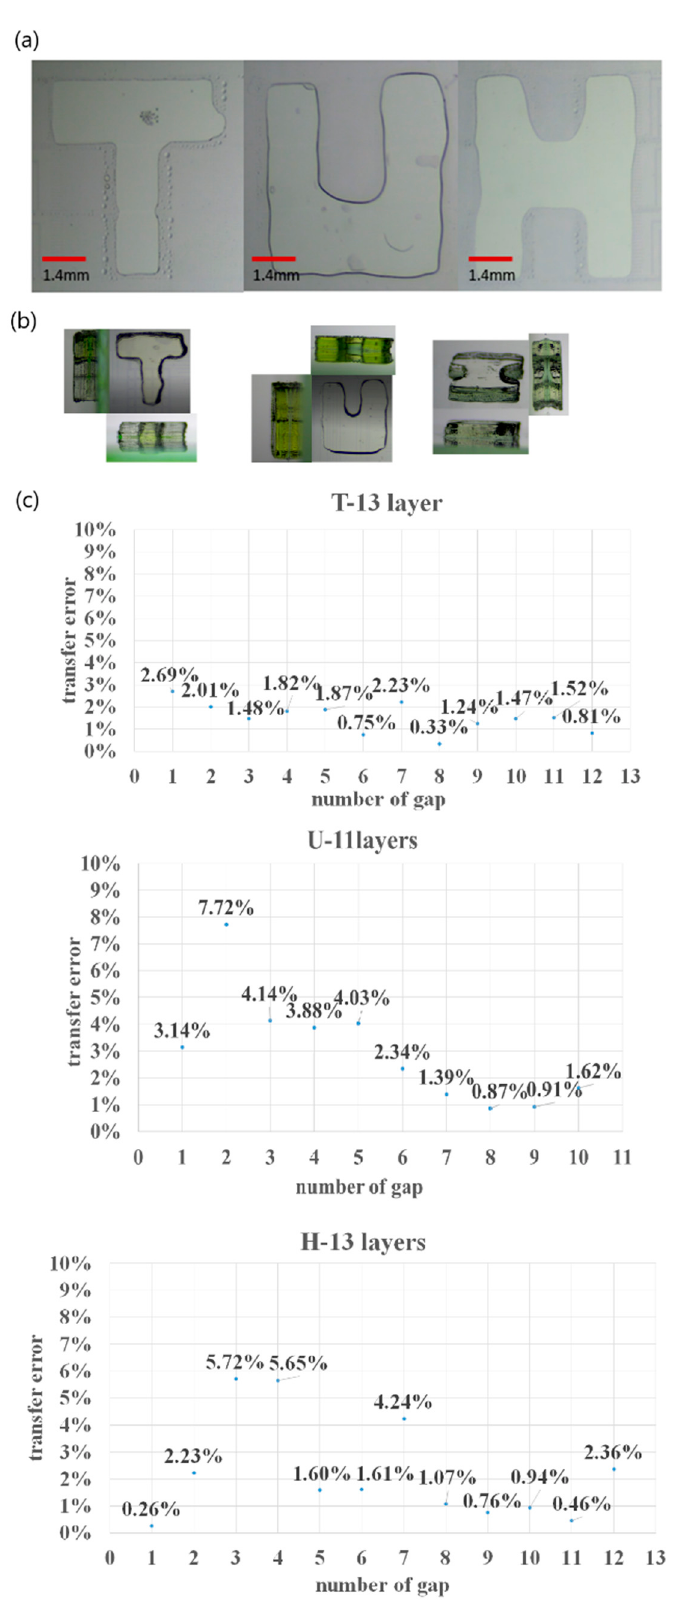
Figure 10. ( a ) First layer structure forming by DEP system, T, U, H; ( b ) 3D stacking structure result of T, U, H with 13 layers, 11 layers and 13 layers, respectively; ( c ) transfer error between each layer during stacking.